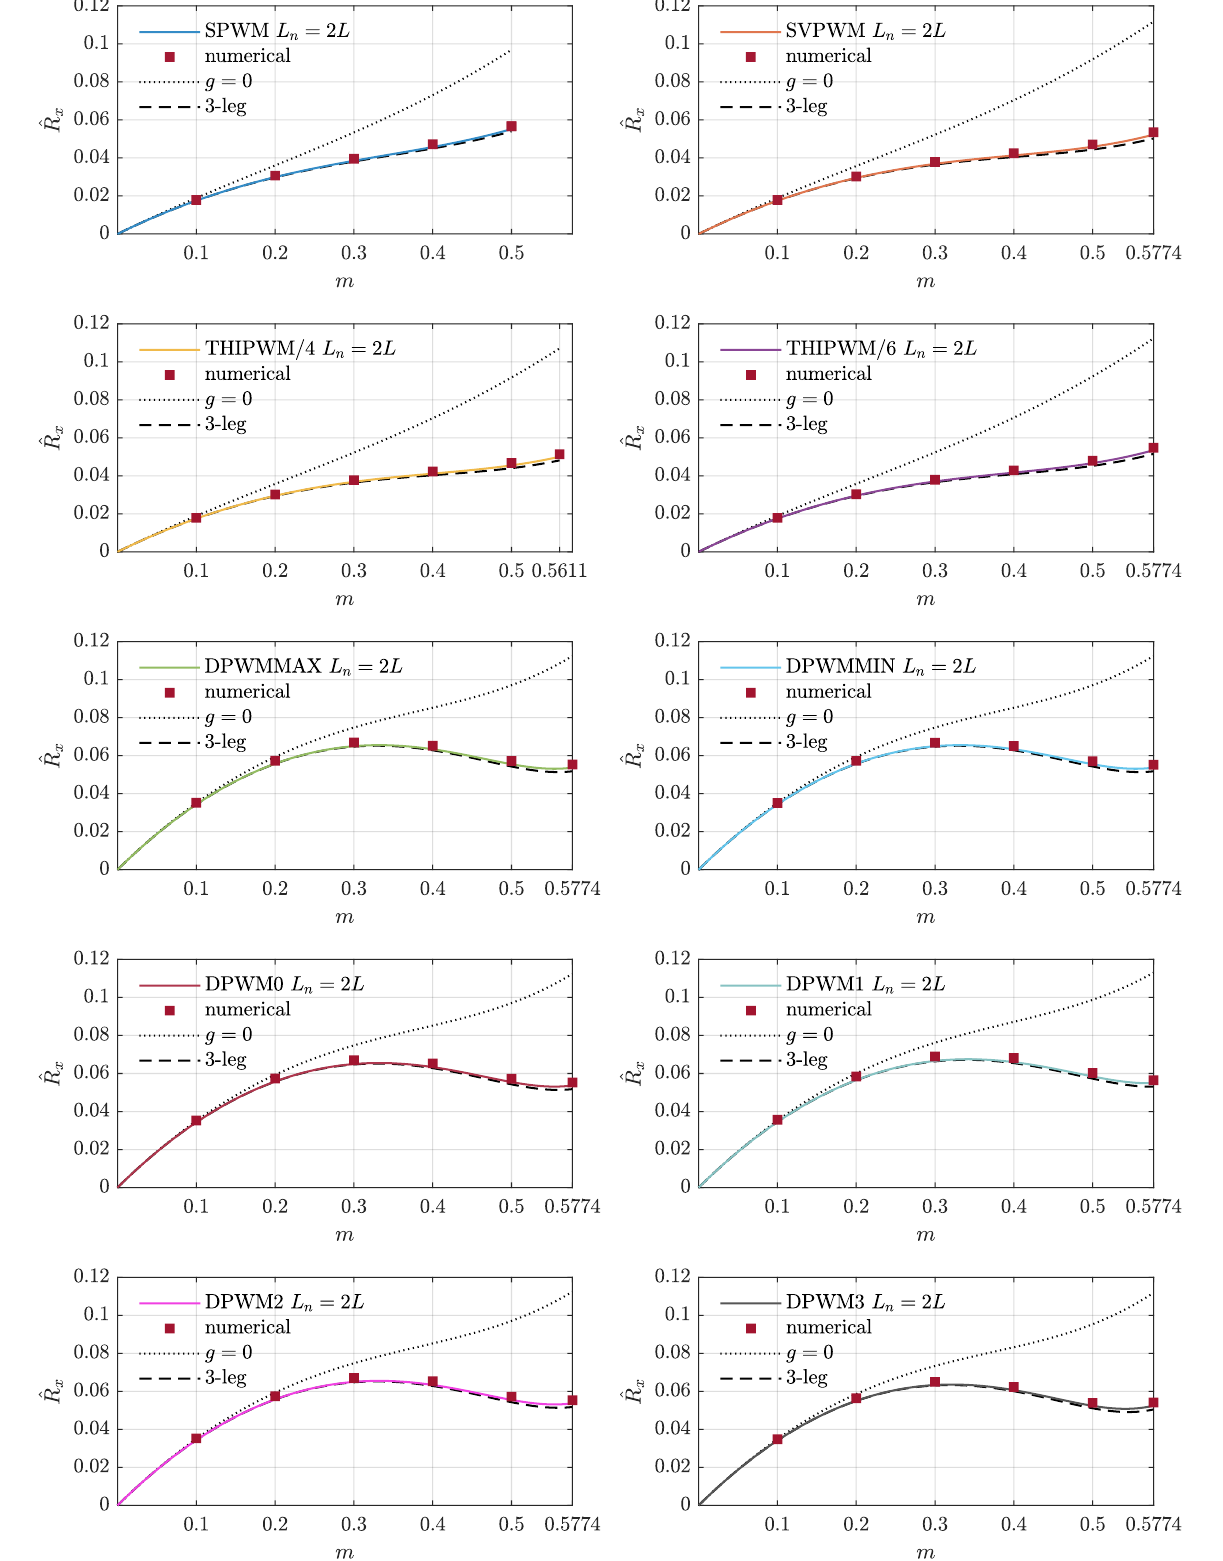
Figure 5. Numerical validation of normalized phase-current-ripple RMS in the case of multiple PWM common-mode injections for L n = 2 L (i.e., g = 2). Normalization base V dc / ( 2 Lf sw )